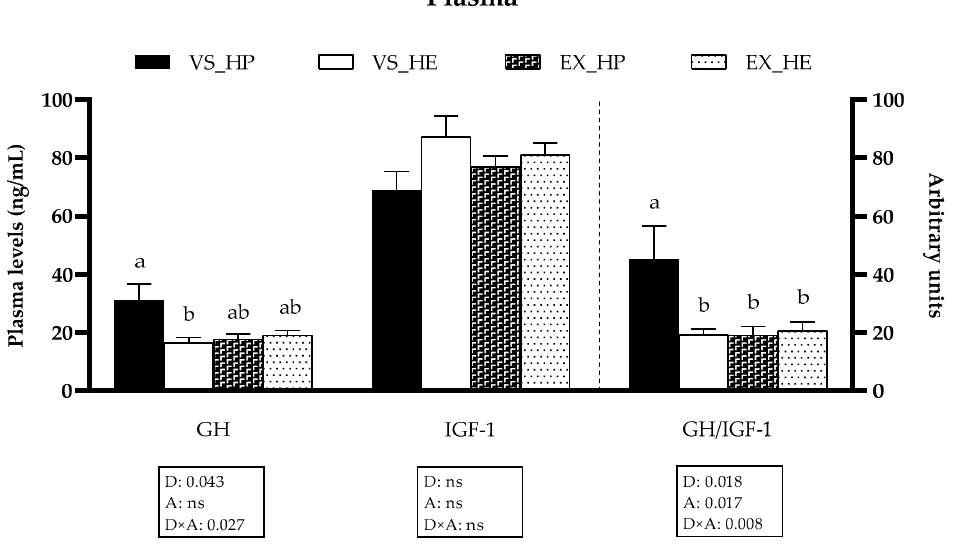
Figure 1. Growth hormone (GH) and insulin-like growth factor-1 (IGF-1) plasma levels of fish under voluntary swimming (VS) or sustained exercise (EX) and fed with high-protein diet (HP) or high-energy diet (HE). Data are shown as means + SEM. VS, n = 10; EX, n = 22. Factorial statistical analysis was assessed by two-way ANOVA, and p -values of factors diet (D), physical activity (A) and interaction (D × ) are displayed under graph. Different letters indicate significant differences (Tukey’s post-hoc test, p <